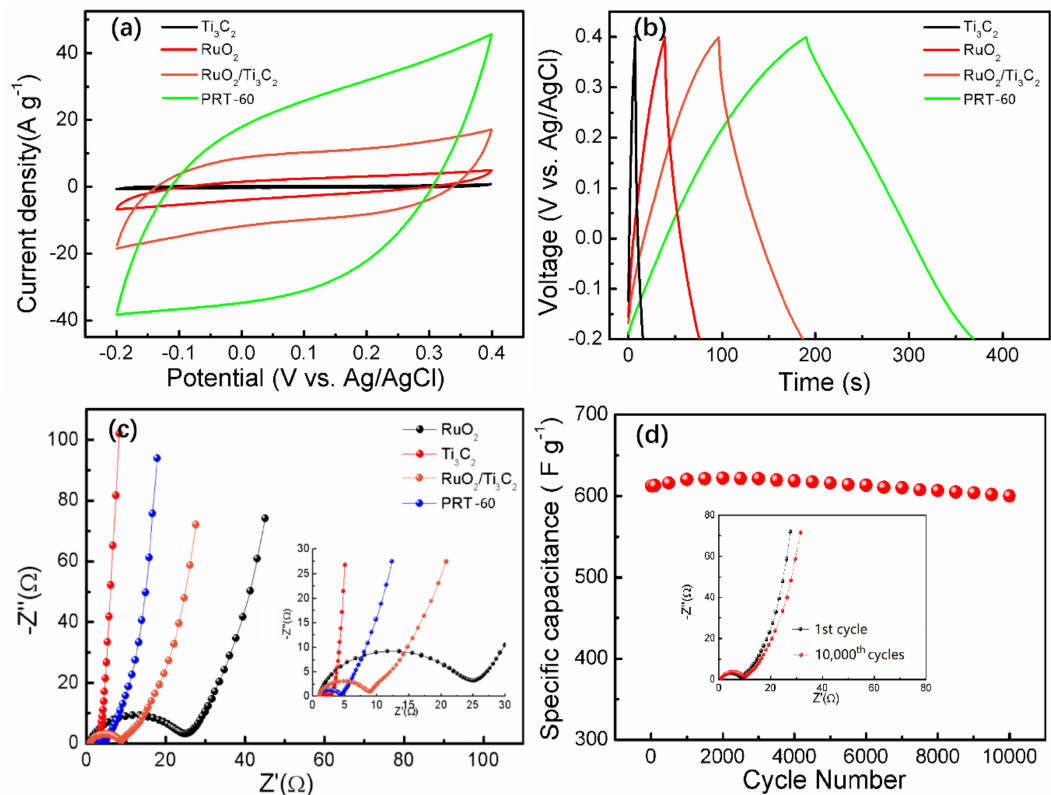
Figure 5. ( a ) Cyclic voltammetry (CV) curves, ( b ) galvanostatic charge–discharge (GCD) curves and ( c ) Nyquist plots of the Ti 3 C 2 , RuO 2 , RuO 2 /Ti 3 C 2 and PRT-60 electrodes; ( d ) long-term cycling test by measuring 10,000 cycles at a constant current density of 2 A g − 1 (the insert shows the EIS values cycles 1 and